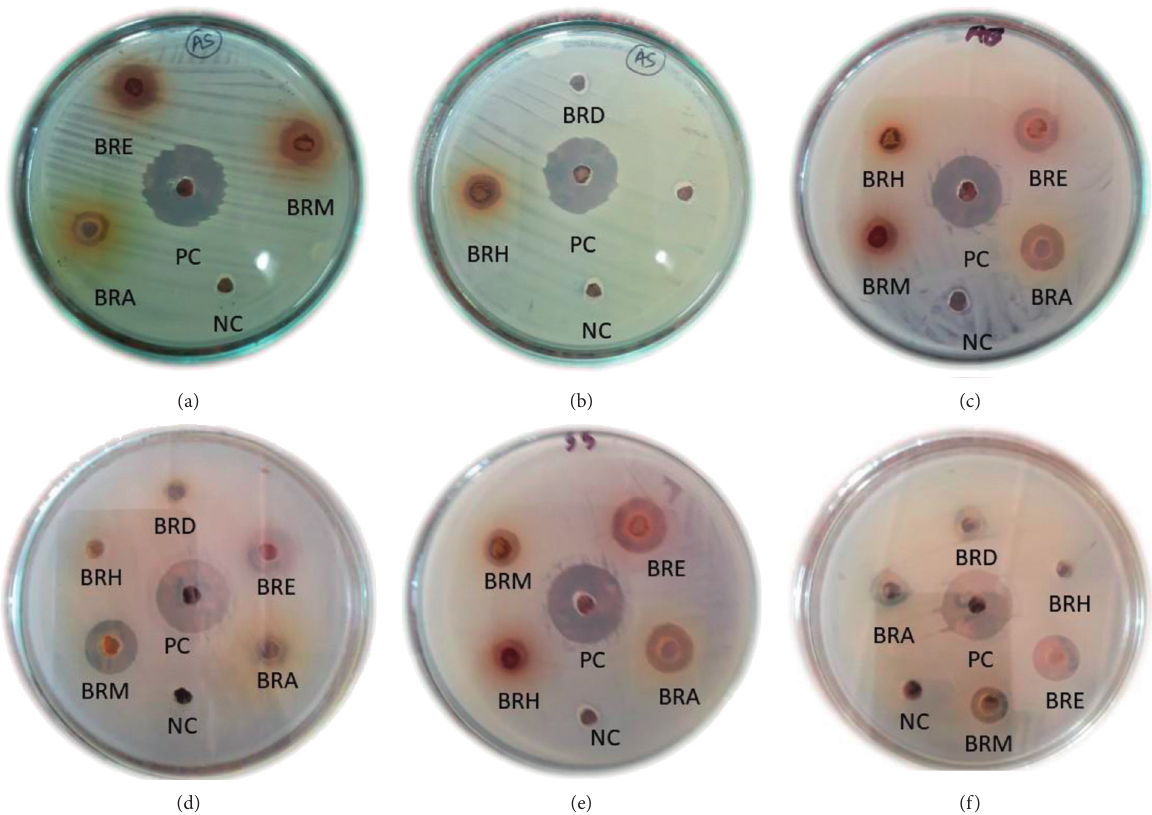
Figure 2: Antibacterial slides: (a, b) S. aureus , (c) A. baumannii, (d) S. sonnei , (e) S. typhi , and (f) K. pneumoniae . PC, positive control; NC, negative control; BRA, aqueous extract; BRE, ethyl acetate extract; BRH, n-hexane extract; BRD, DCM extract; and BRM, methanol